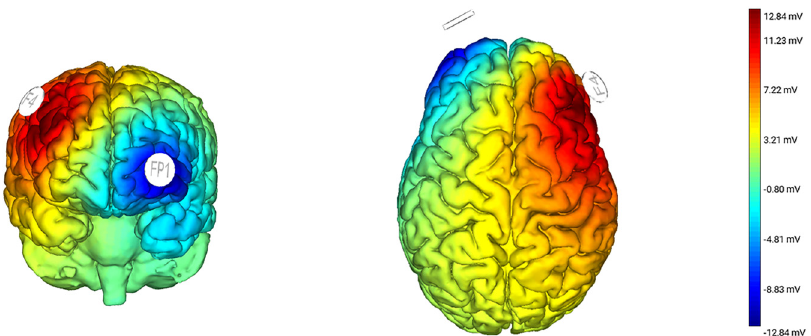
Figure 1. Electrode configuration and current flow in the cathodal tDCS group. Pictures are executed using the software Neuroelectrics ® Instrument Controller (NIC, version 2.1.0). using the software Neuroelectrics ® Instrument Controller (NIC, version